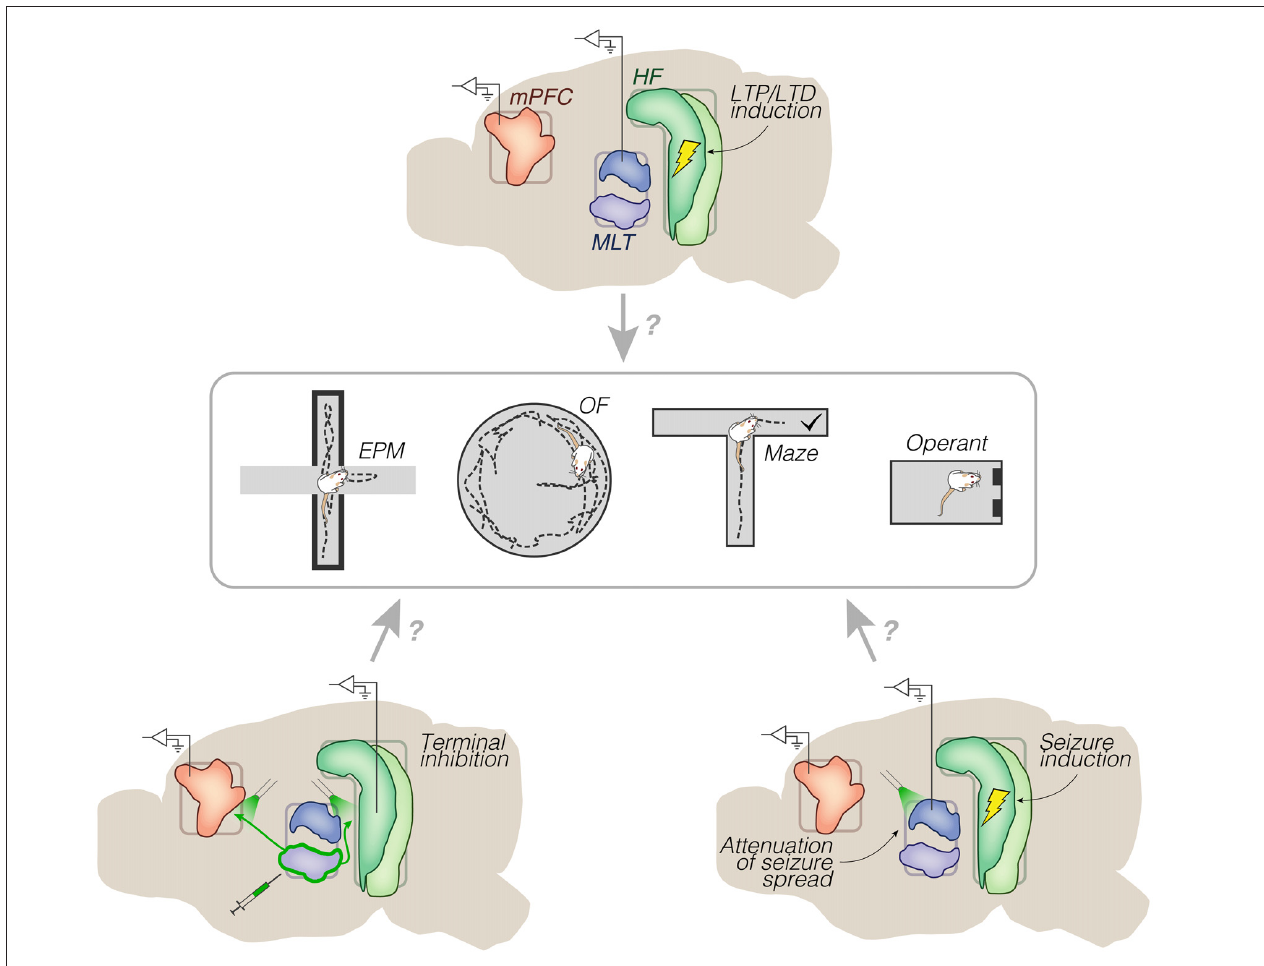
FIGURE 6 | Representative research directions. Chronic implants (mid sagittal views) surrounding a set of behavioral testing options. Top: electrical trains of pulses into the HF, and monitoring of long-term effects on spontaneous and/or evoked activity (e.g., from prelimbic cortex or dorsal midline thalamus). No distinction is made between dorsal, intermediate and ventral domains of the HF. Bottom left: optogenetic inhibition of archaerhodopsin-transfected efferents from the ventral midline thalamus. Bottom right: optogenetic attenuation of electrically-induced seizures from the HF. These implant strategies could be used in animal models of brain disorders, including schizophrenia and epilepsy. Abbreviations: EPM, elevated plus maze; HF, hippocampal formation; LTD, long-term depression; LTP, long-term potentiation; MLT, midline/paramidline thalamus; mPFC, medial prefrontal cortex; OF, open